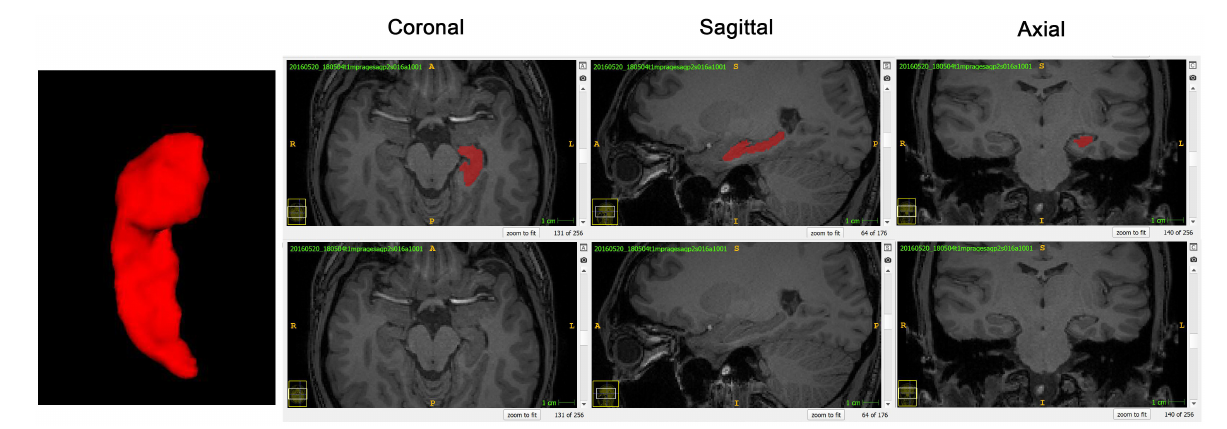
consistency of the two segmentations, which was also used in our previous publication (Ge et al.,